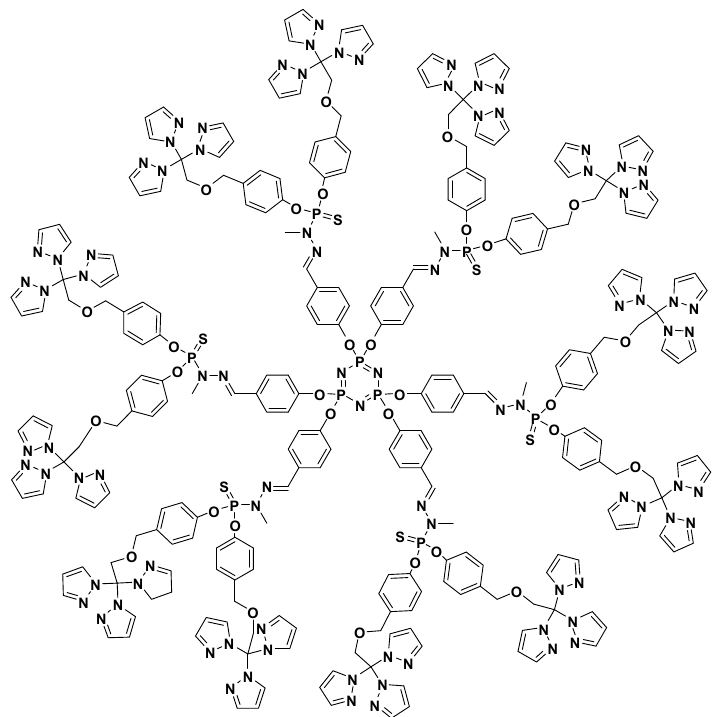
Figure 3. The new tris(pyrazolyl)methane-based phosphorus dendrimer N 3 P 3 -G c1 -[CH 2 C(pz) 3 ] 12 ( 7 ). A synthetic alternative using the iodo-benzyl derivative (N 3 P 3 -G c1 -I 12 ) [49] of the dendrimer molecule in the presence of tris-2,2,2-(1-pyrazolyl)ethanol ( 1 ) and sodium hydride was also successful to obtain the tris(pyrazolyl)methane-based phosphorus dendrimer N 3 P 3 -G c1 -[CH 2 C(pz) 3 ] 12 ( 7 ) (Scheme 6) in moderate yield. Molecules 2018 , 23 , x FOR PEER REVIEW